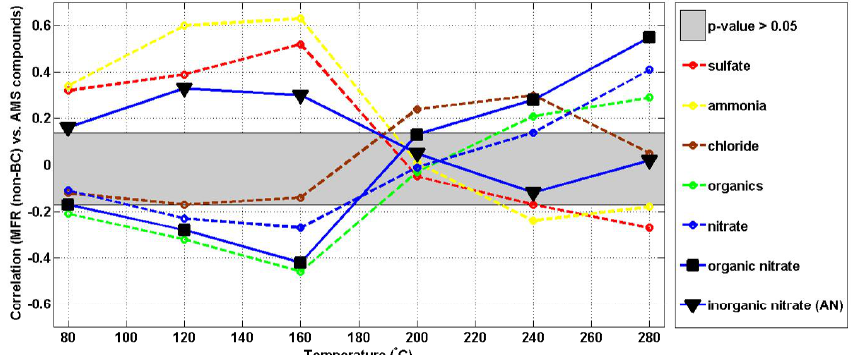
Fig. 10. Correlation coefficients between MFR non-BC at 280 ◦ C and mass fractions of AMS-compounds at six different temperatures. Mass concentrations (/fractions) of ammonium nitrate (AN) and organic nitrate were estimated from the AMS data. The grey area presents the correlation range ( r = − 0 . 17...0.14) where the correlations start to approach an area of not being statistically significant (p-value >